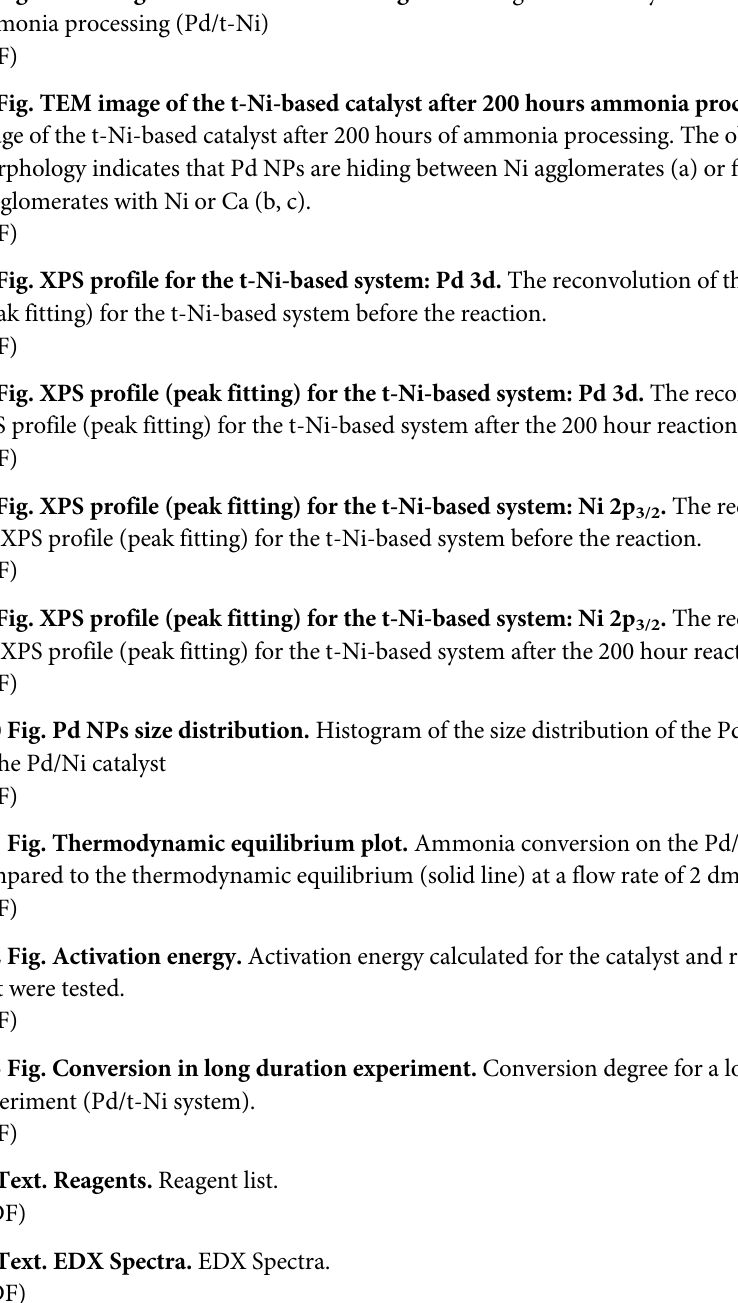
. The reconvolution of 3/2